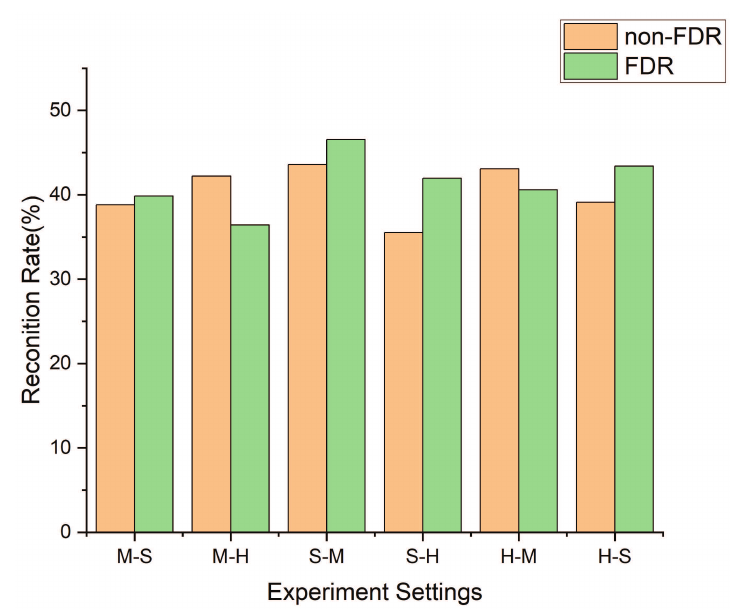
Figure 2. The results of the experiments for the FDR and